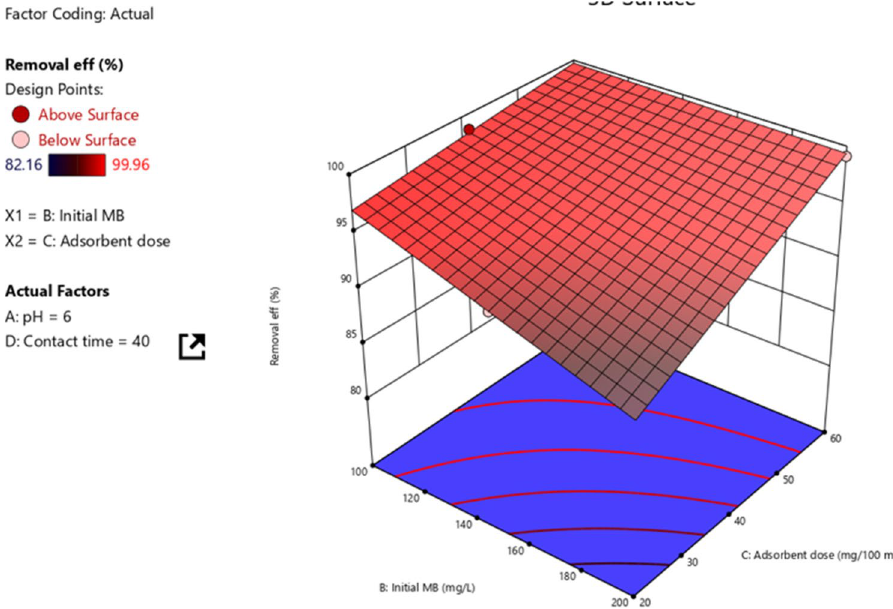
Figure 6. Interaction effects of initial MB concentration and adsorbent dosage.